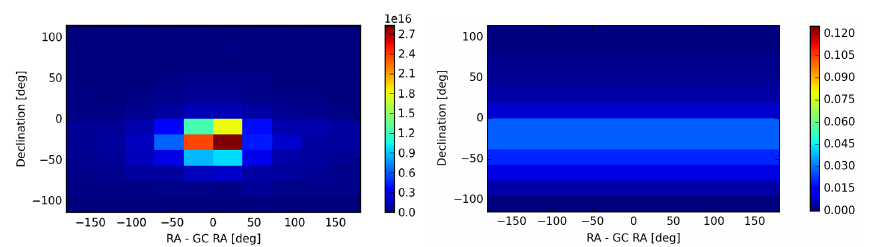
Figure 2. PDFs for IceCube as a function of declination and right ascension for signal (left) and background (right). The signal is for a τ + τ − annihilation channel, NFW profile and M χ = 100 GeV / c 2 .